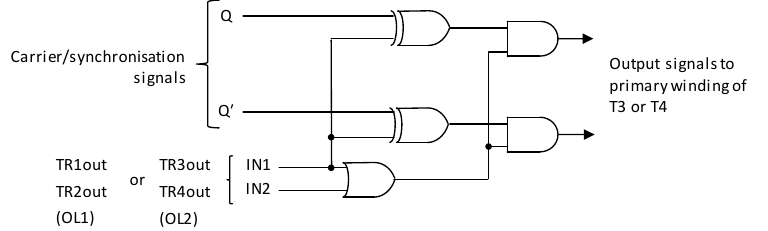
Figure 7. Logic circuitry within each of the output logic blocks OL1 and OL2 in Figure 6.